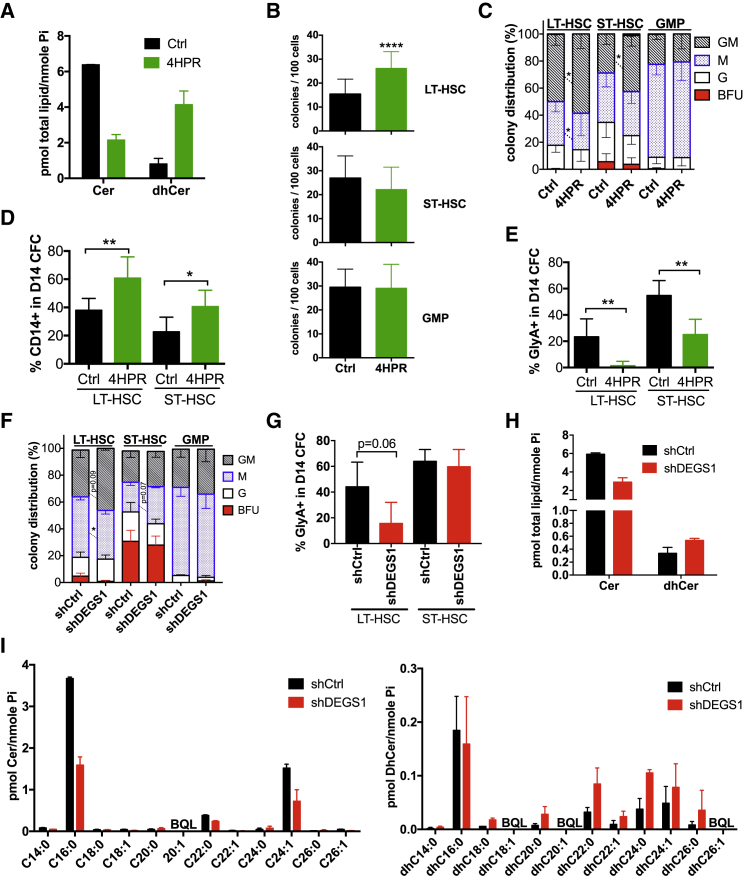
Sphingolipid Modulation of DEGS1 Alters HSC Function and Lineage Balance In Vitro(A) Total Cer and dhCer levels in lin− CB progeny cultured for 8 days with control or 4HPR (n = 2).(B and C) LT-HSC, ST-HSC, or GMP CFC assays in the presence of Ctrl or 2 μM 4HPR showing (B) colonies/100 cells and (C) colony distribution (n = 12; CB).(D and E) Flow cytometry for (D) monocytic (CD14+) and (E) erythroid (GlyA+) markers in live cells from pooled CFC colonies (n = 6; CB).(F) Colony distribution in CFC assays with LT-HSC, ST-HSC, or GMP cells transduced with shCtrl or shDEGS1 (n = 4; CB).(G) Flow cytometry for erythroid cells from pooled CFC colonies in (F).(H and I) hCD45+BFP+ lacking the CD34+CD19− population were isolated from shCtrl or shDEGS1 mice at 4 weeks post-transplant (n = 2 CB) and profiled by LC/MS for (H) total Cer and dhCer levels and (I) normalized Cer and dhCer profiles with the indicated fatty-acyl chain. BQL, below quantitation level.∗p < 0.05; ∗∗p < 0.01; ∗∗∗p < 0.001.